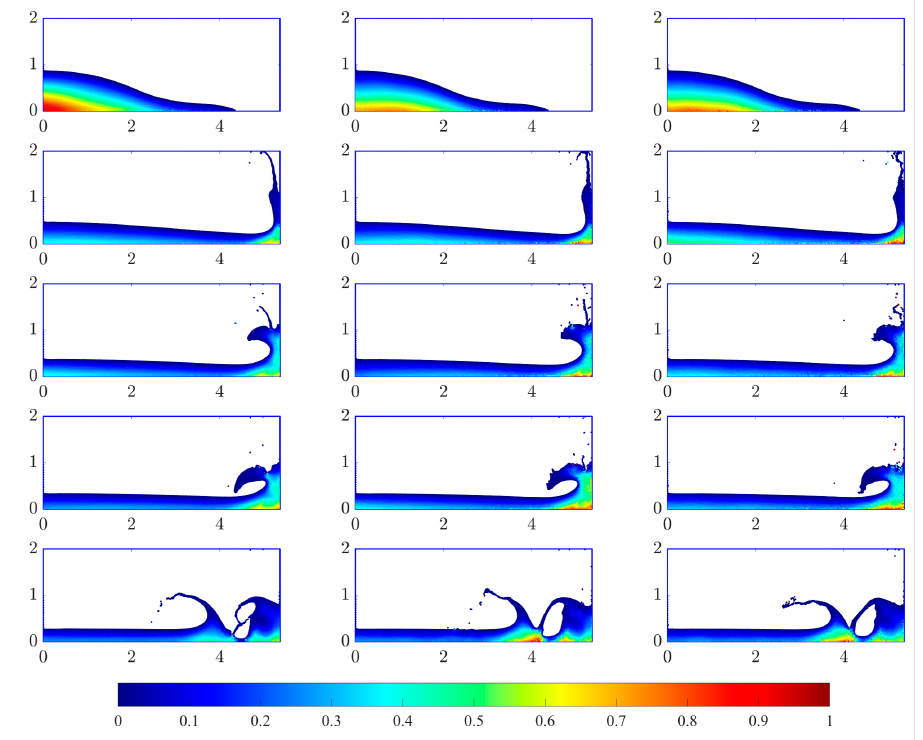
Figure 6. Pressure contour plots at different times for the dam-break simulations by using the Wendland kernels. The pressure and time values have been non-dimensionalized using P (cid:1) 0.5 (cid:0) g t , respectively. The times are 1.94, 4.52, 5.49, 5.98 and 7.12 units from top to bottom. The plot H columns from left to right are for the WC2, WC4 and WC6 kernels, respectively.